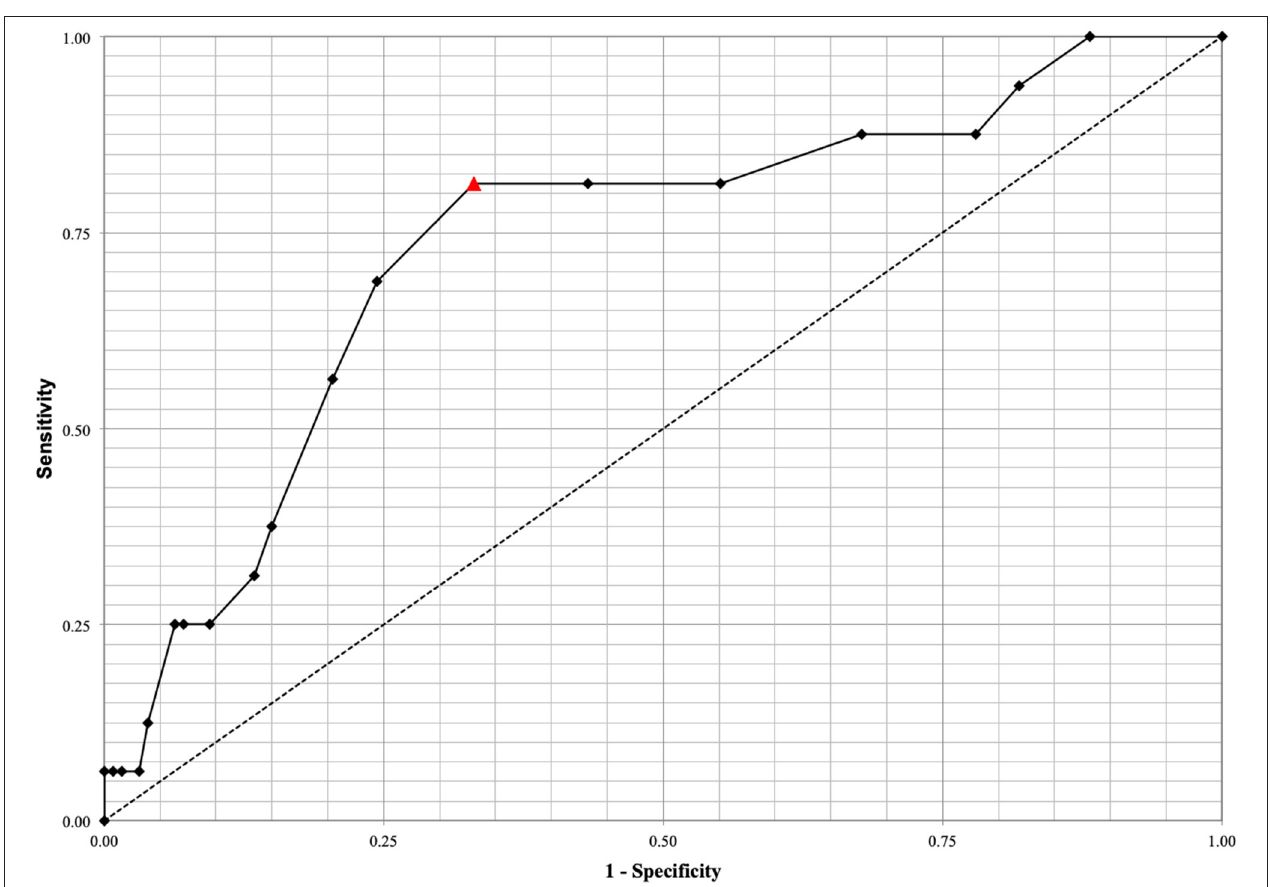
FIGURE 2 | ROC analysis for the prediction of shunt-dependent hydrocephalus demonstrated that monocyte count exhibits an acceptable area under the curve (AUC = 0.737, 95% CI: 0.601–0.872, p < 0.001). The best predictive cutoff value to discriminate between successful EVD weaning and shunt-dependent hydrocephalus was identified at a monocyte count ≥ 0.80 × 10 3 /uL with a sensitivity and specificity of 81.25% and 66.93%, respectively. The optimal cutoff value of monocyte count on admission is depicted by the red triangle.